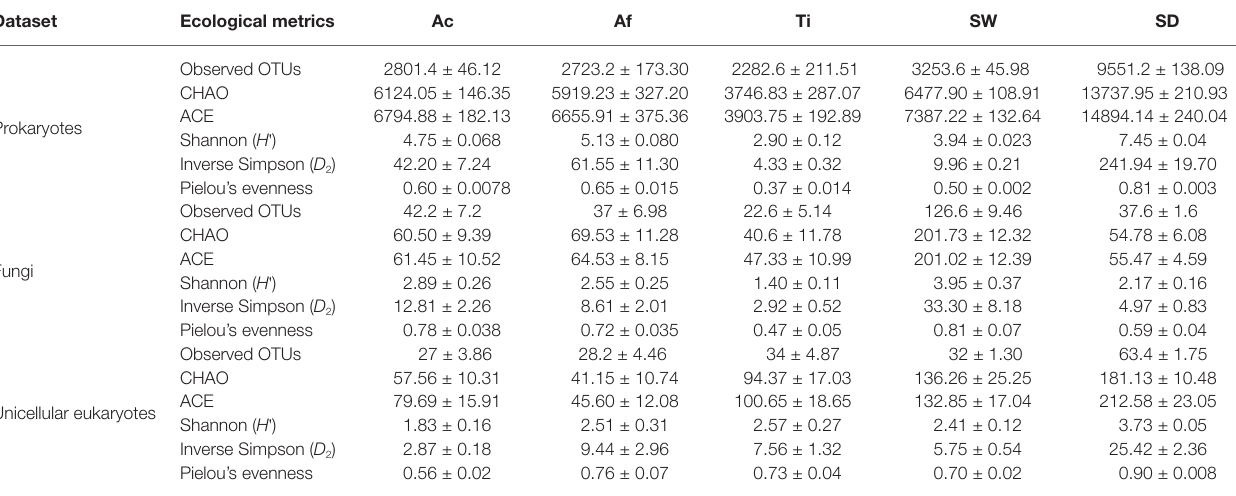
TABLE 1 | Values for richness, diversity, and evenness